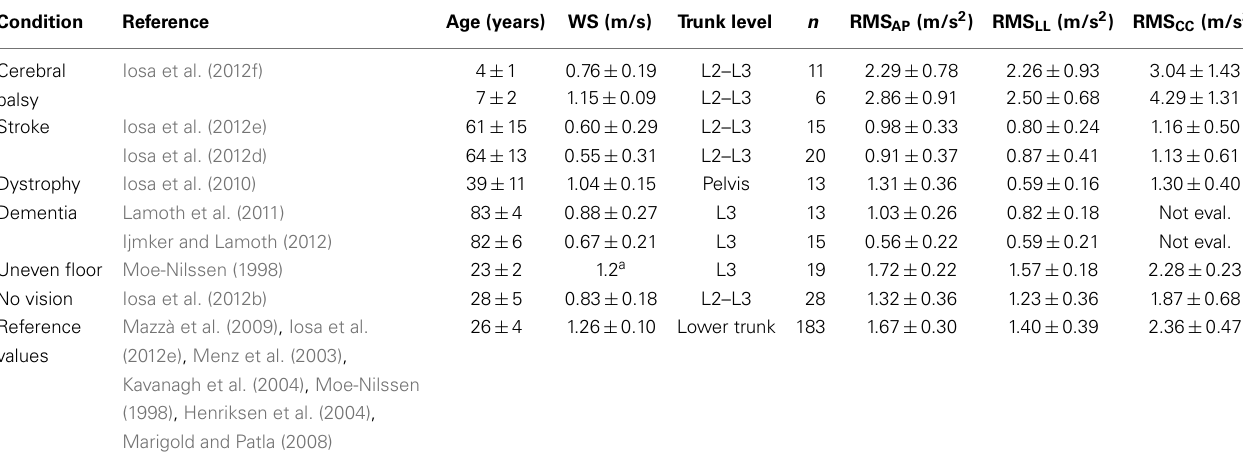
Table 2 | Gait stability data of subjects with a pathology or healthy subjects walking on uneven floor or without vision support, with respect to reference values obtained as the average of means ( ± SDMs) reported in studies on young healthy adults